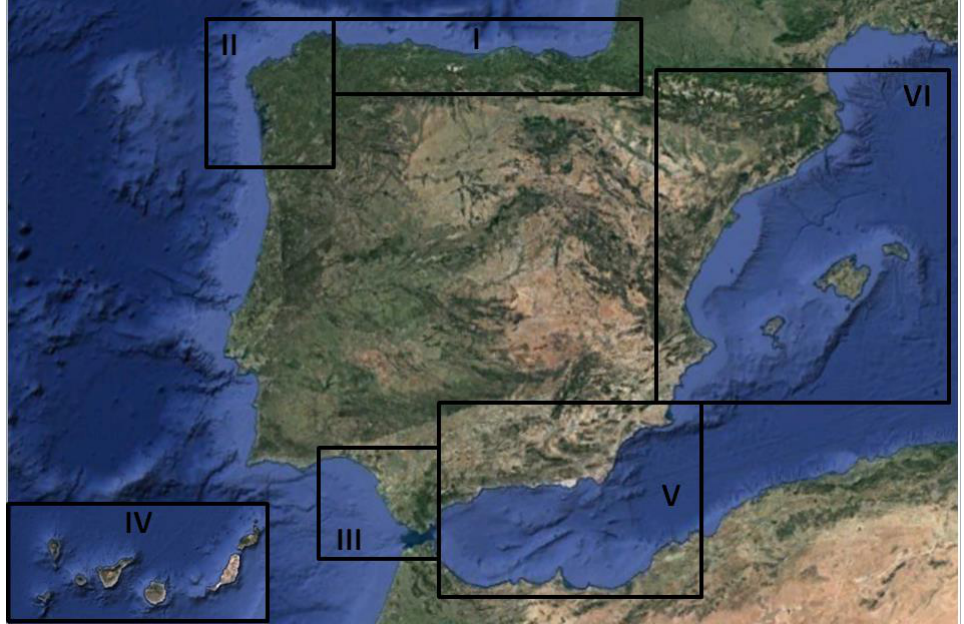
Figure 10. Zoning created for the study of marine renewable resource in the Spanish coast.